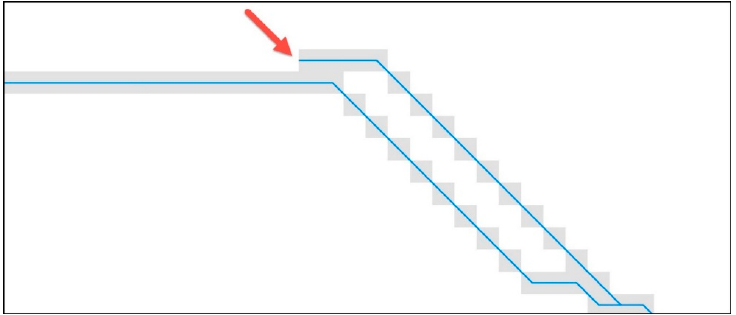
Figure 1. An undesirable situation according to the BeST approach: a drainage line starting from a cell adjacent to one of the cells containing an existing drainage line.